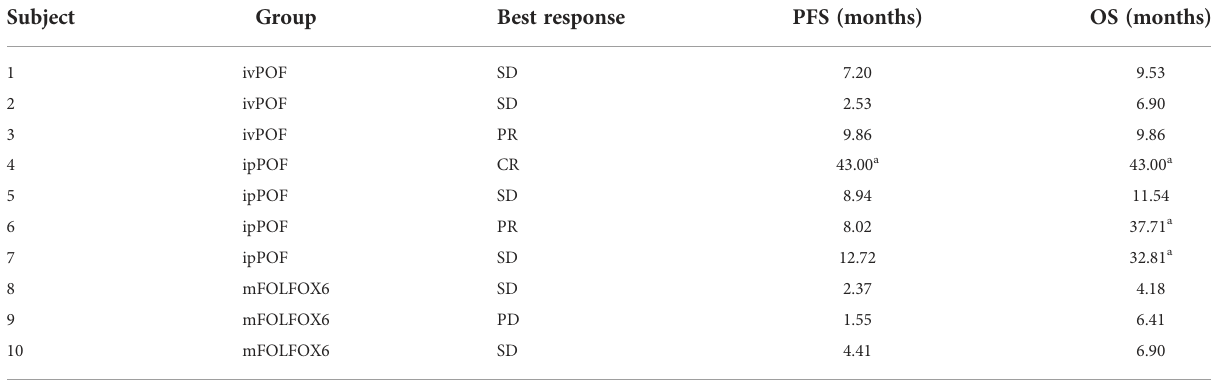
TABLE 3 Therapeutic ef fi cacy in HER2-positive